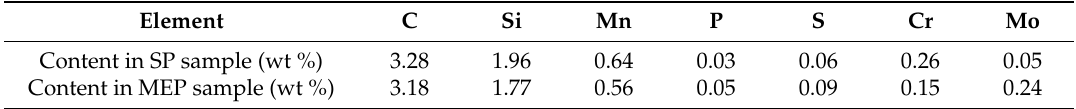
Table 1. Chemical composition of the alloys.